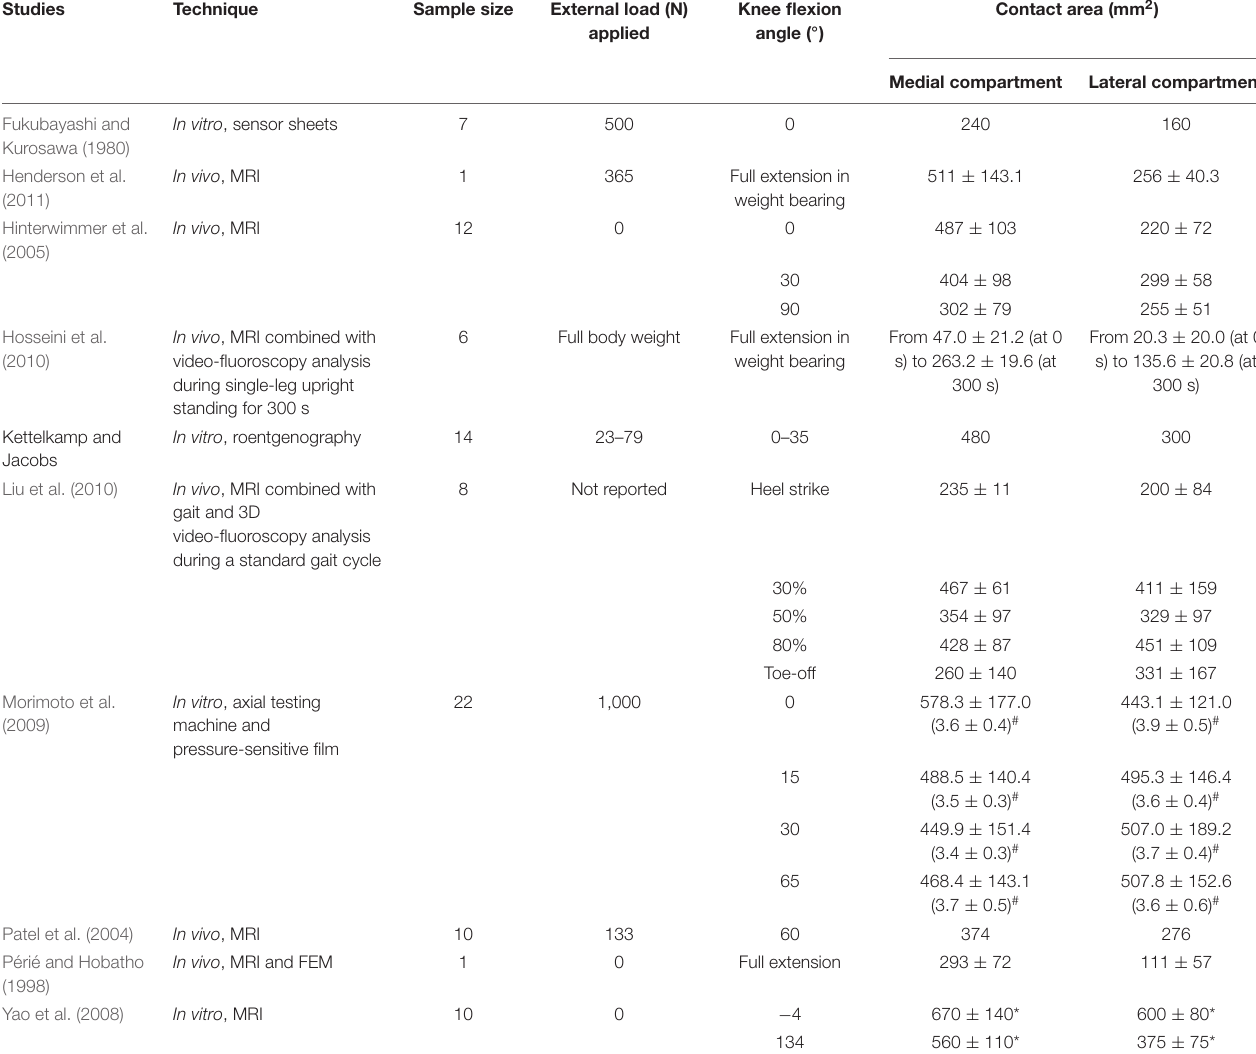
TABLE 1 | Knee joint contact areas as from a critical literature